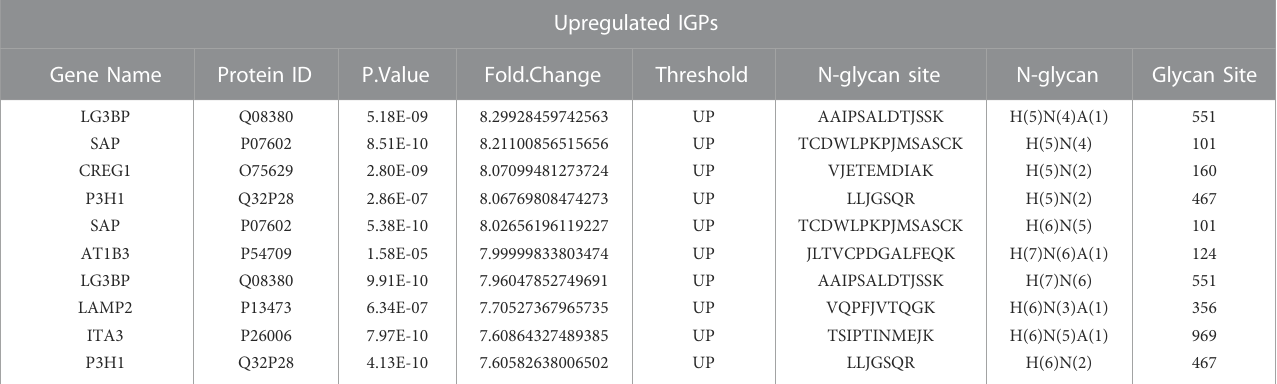
TABLE 2 Top ten upregulated IGPs identi fi ed through glycoproteomics